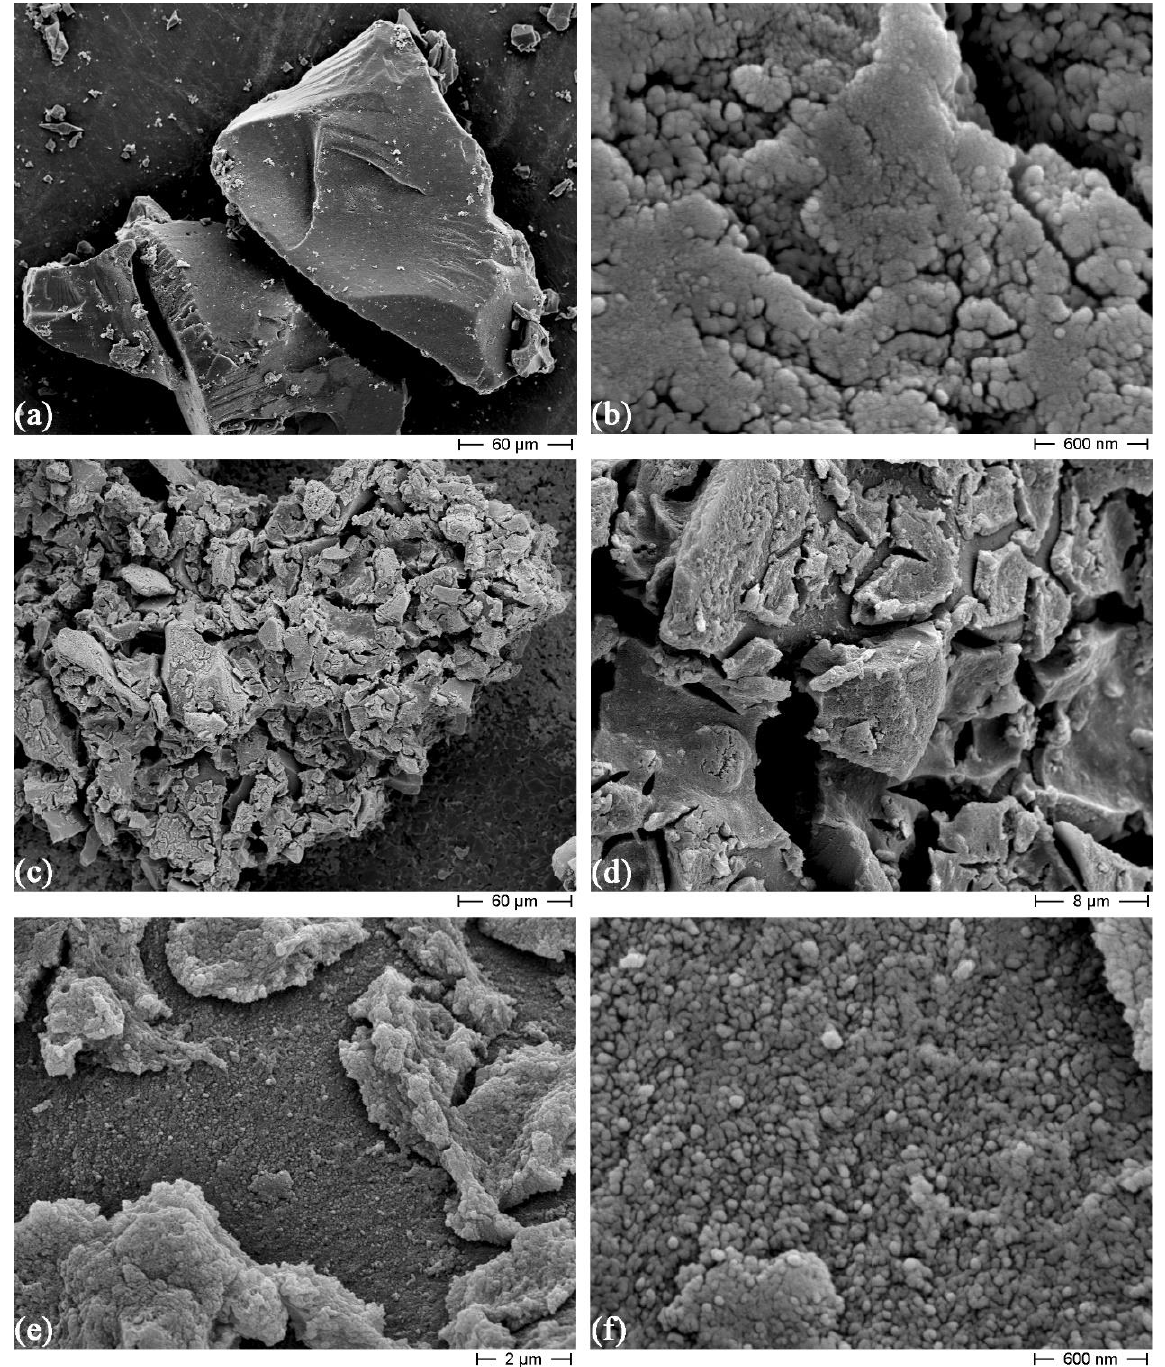
Figure 5. FESEM micrographs of: S1 powder after calcination at 500 °C for 5 h ( a , b ); screen-printed S1 sensor at various magnifications, after calcination at 550 °C for 1 h ( c – f ).